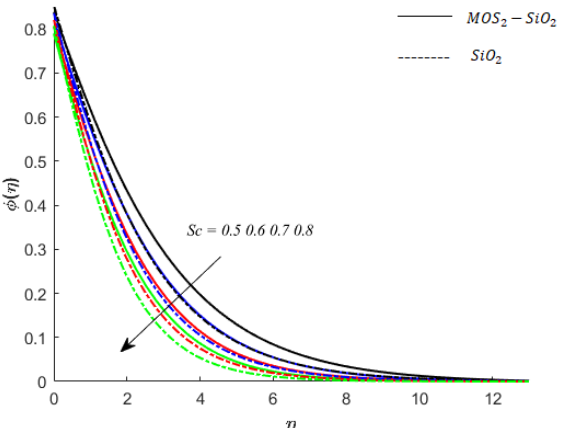
Figure 11. Influence of Sc on concentration when M = 0.9, Pr = 0.9, Ec = 0.2, K = 0.1, Ei = 0.1, Bi = 0.05, β ∗ = 0.1, γ = 0.1, γ 1 = 0.1. Concentration of fluid particles and solutal relaxation time: The effects of thermal relaxation time on the temperature of fluid particles are similar to the impact of solutal relaxation time on the concentration field (compare Figures 10 and 12).